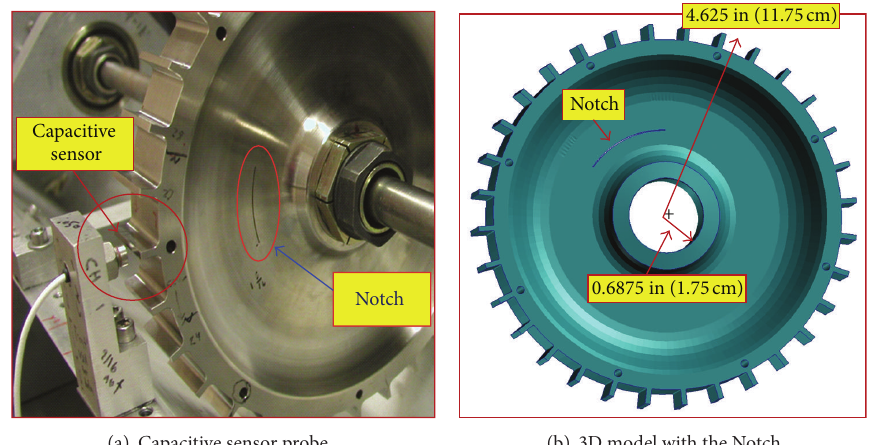
Figure 1: Test disk capacitive sensor assembly.